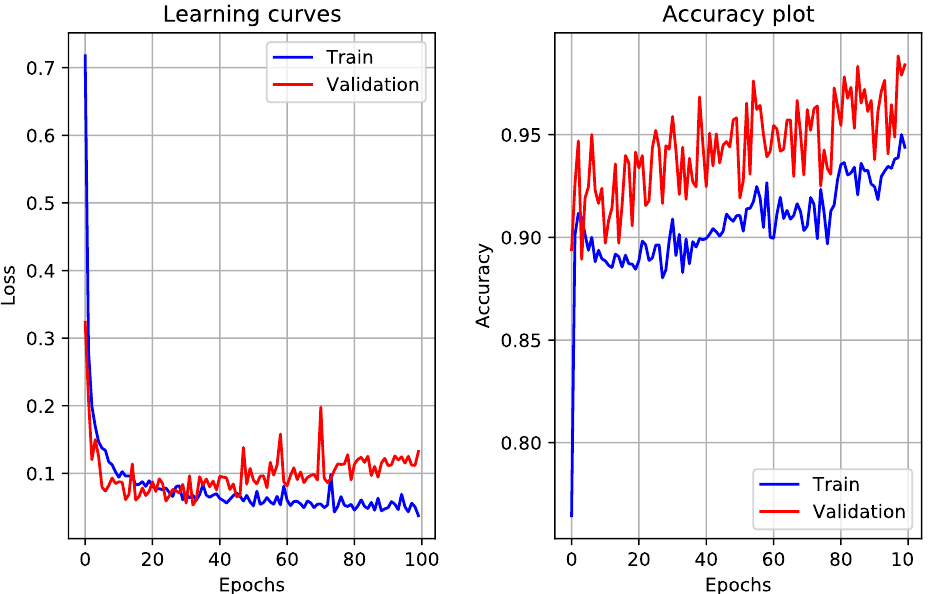
Figure 19. Learning curves and Accuracy plot for LoRa data for 0.01 learning rate and 100